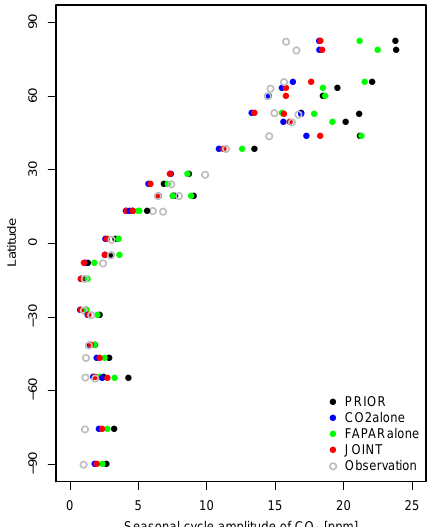
Figure 5. Latitudinal distribution of atmospheric CO 2 seasonal cy- cle amplitude, calculated as the difference between the maximum and minimum CO 2 mole fractions of the averaged seasonal cycle of the linearly de-trended signal from 2005 to